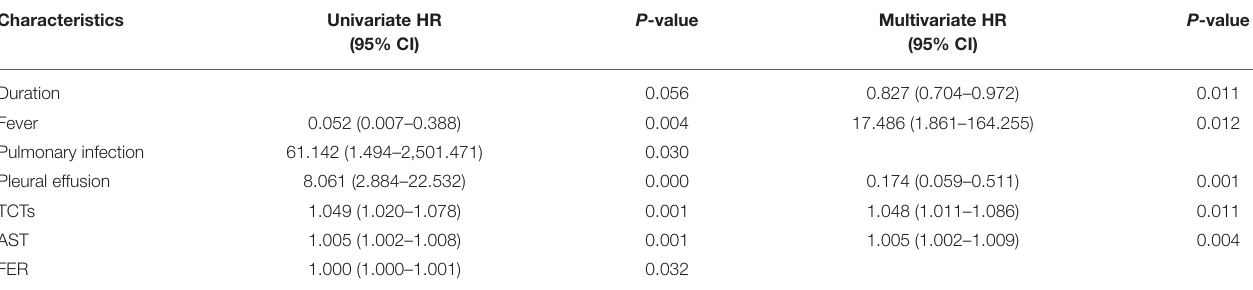
TABLE 6 | Cox regression analysis of various predictive factors for the prognosis of MDA5 + DM-ILD. Characteristics